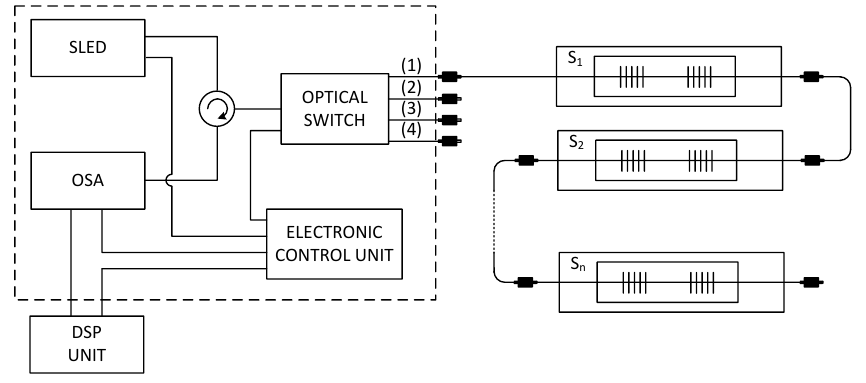
Figure 5. The measurement scheme of our multichannel hybrid fiber-optic sensor